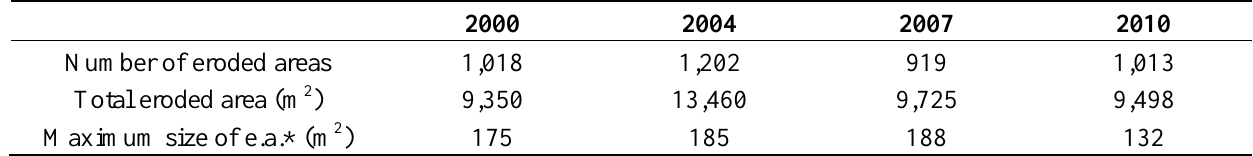
Table 1. Occurrence of shallow eroded areas in the four years.